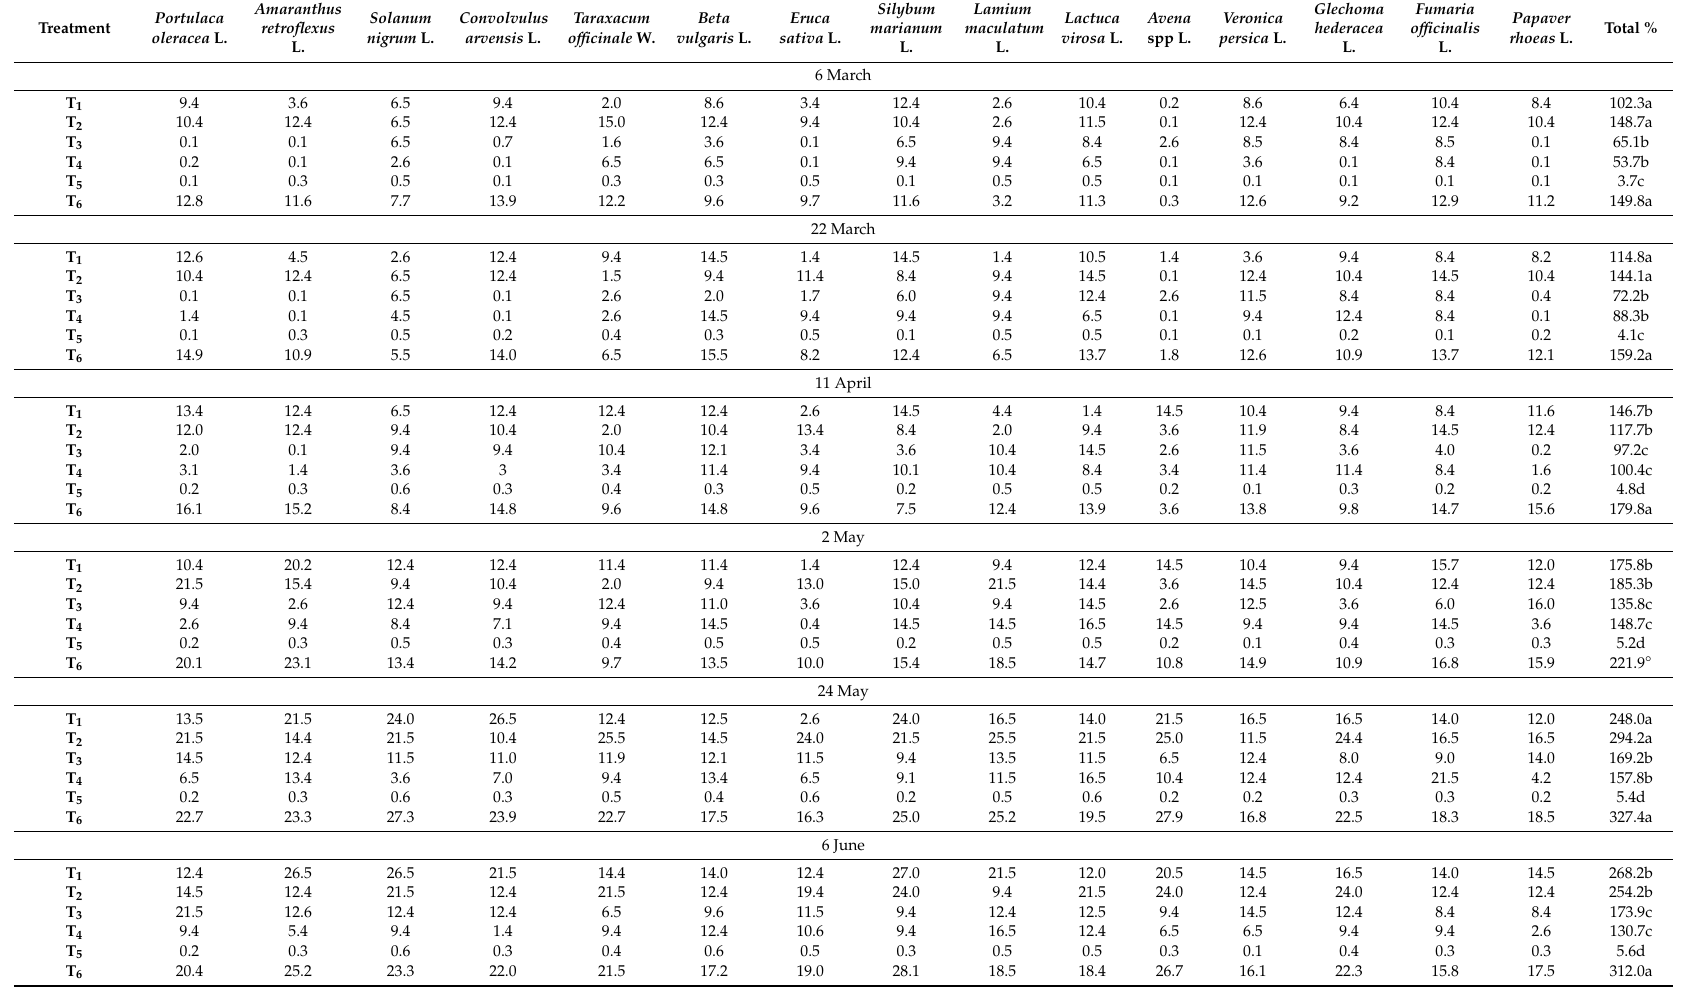
Table 2. E ff ect of treatments on weed ground cover percentage (WGC %) at di ff erent surveys during the 2011–2012 season.